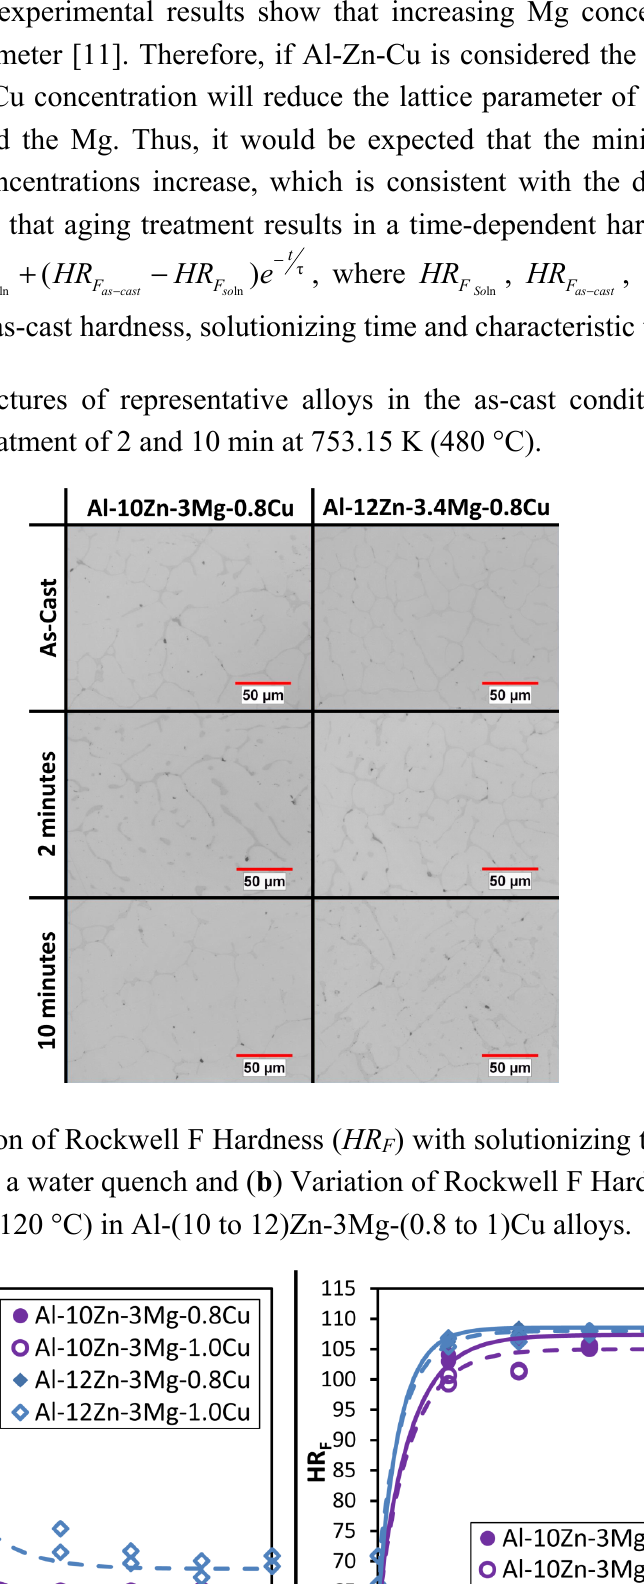
) with solutionizing time at 753.15 K F ) with F